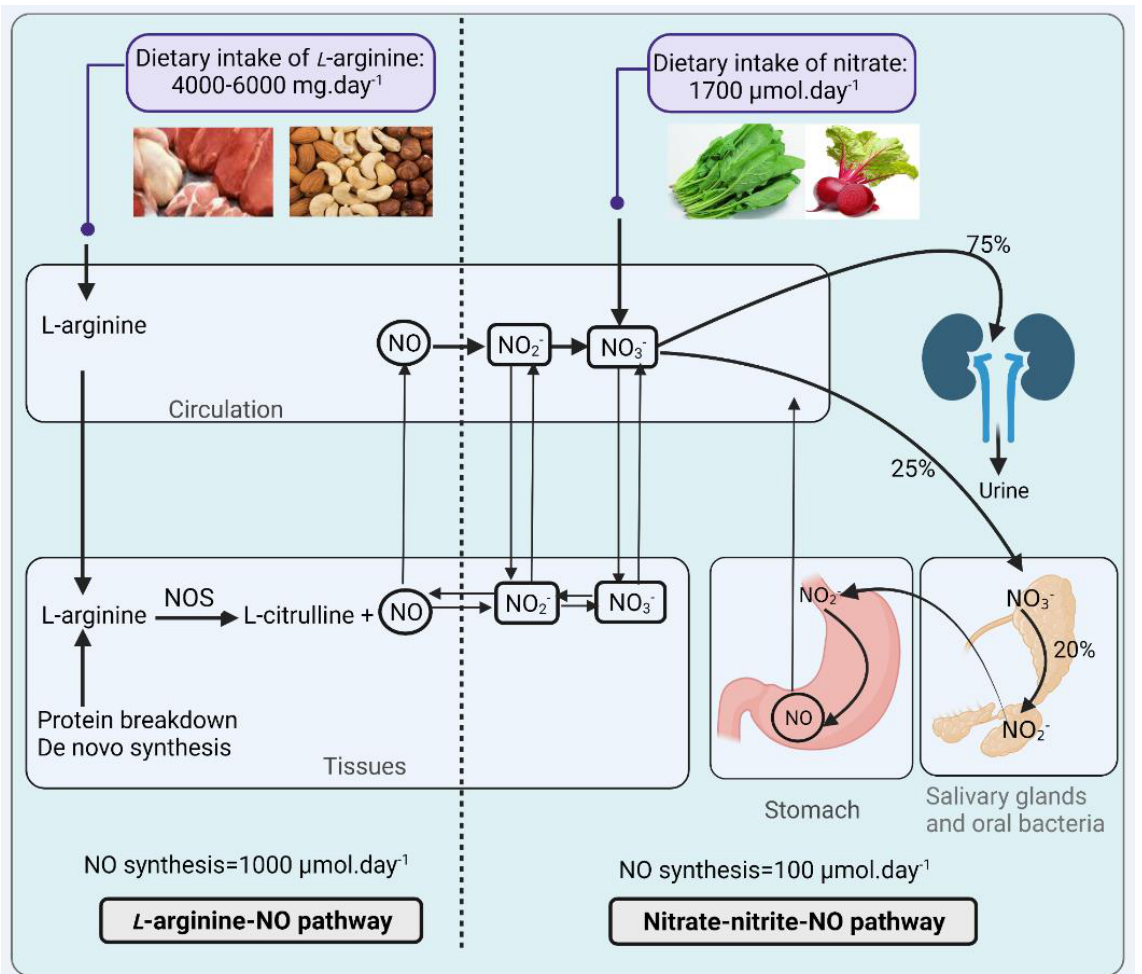
Figure 1: Pathways of nitric oxide (NO) production. NOS, NO synthase; NO 3- , nitrate; NO 2- , nitrite. Cre- ated with